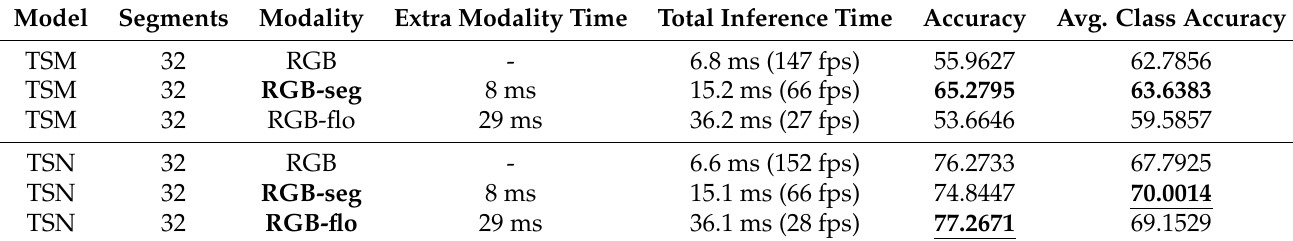
Table 3. Results of TSM and TSN with different modalities using the complete IPN Hand dataset.